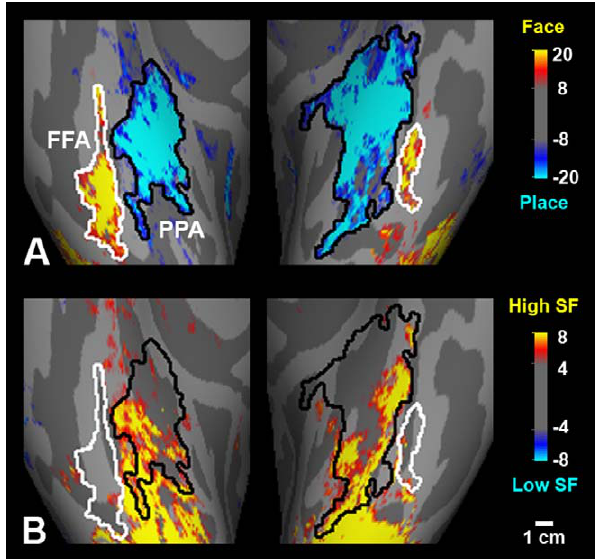
Figure 6. High-pass-filtered place images also activate human PPA selectively. (A) The comparison of responses to faces versus places showed FFA and PPA in the averaged map of four human subjects. The group-averaged activity map is displayed on a ventral view of an averaged inflated cortical surface; the left hemisphere is shown on the right. (B) The comparison of responses to high SF places versus low SF places revealed a high SF bias within PPA, in the averaged map of the same four subjects. The high SF patch was prominent in the lateral-posterior subdivision of PPA. As a control, FFA did not show any differential activity for SF variation.